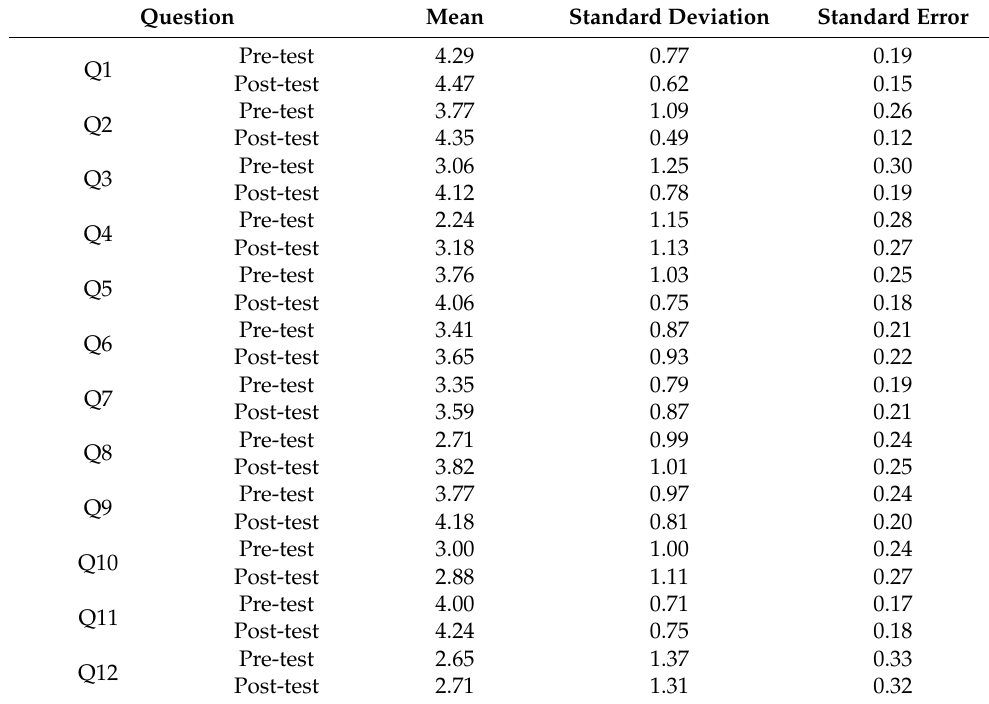
Table 3. Questions included in the questionnaire. All of them were evaluated using a Likert